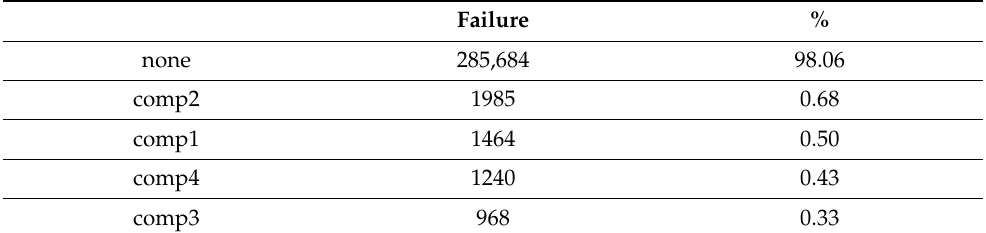
Table 13. Example of the imbalance between the different classes for the ‘failure’ feature in the total data